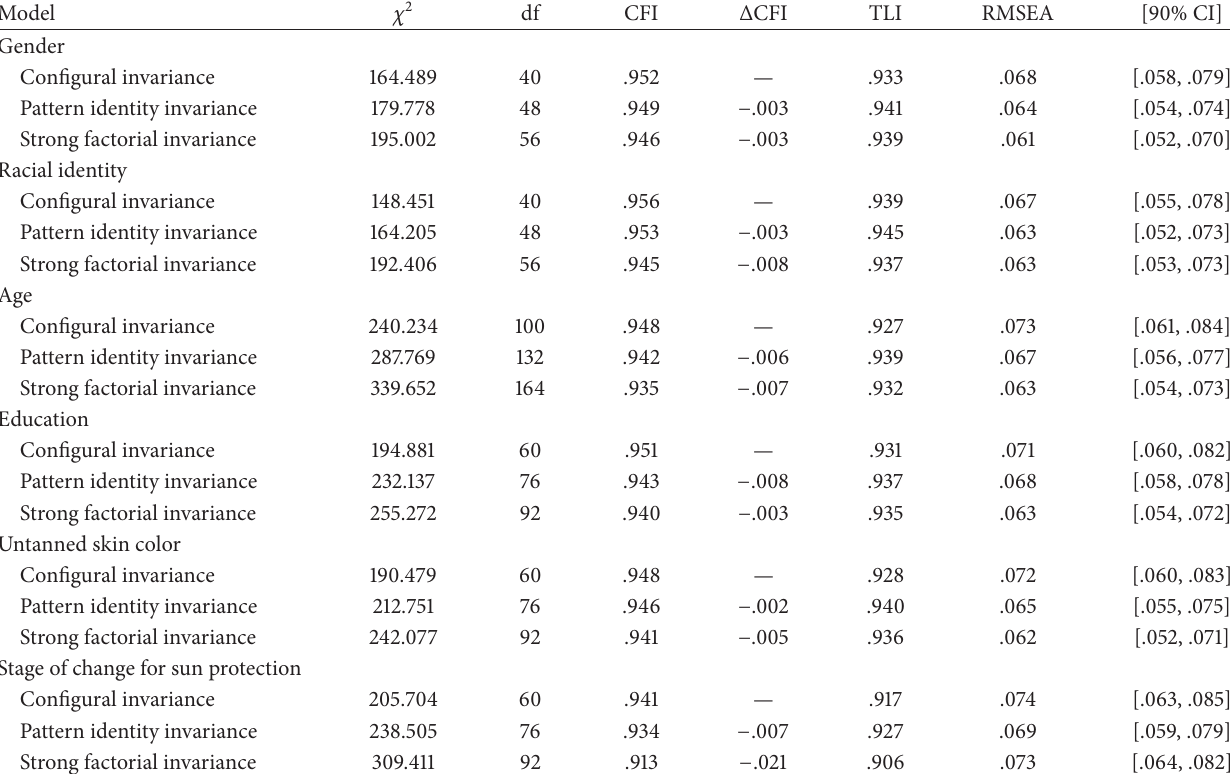
Table 2: Goodness-of-fit statistics for three nested invariance models.